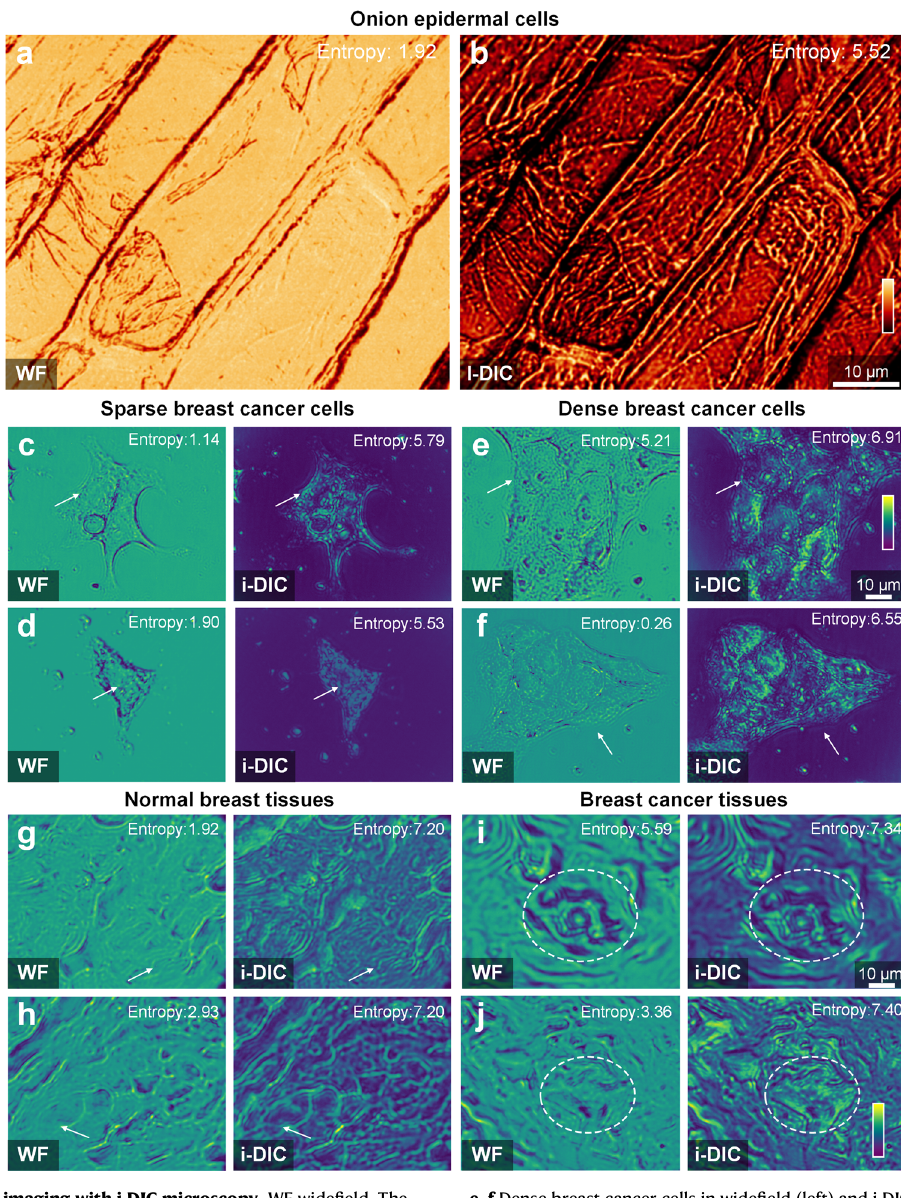
e , f Dense breast cancer cells in wide fi eld (left) and i-DIC (right) microscopy. g , h Normal breast tissues in wide fi eld (left) and i-DIC (right) microscopies. i , j Breast cancer tissues in wide fi eld (left) and i-DIC (right)